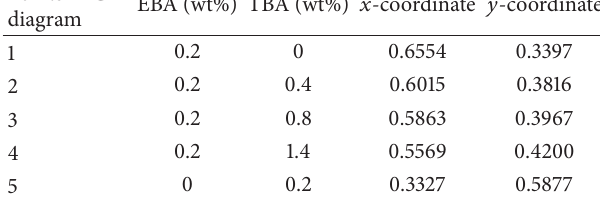
Table 3: CIE chromaticity coordinates of the lanthanide complexes coincorporated PMMA.